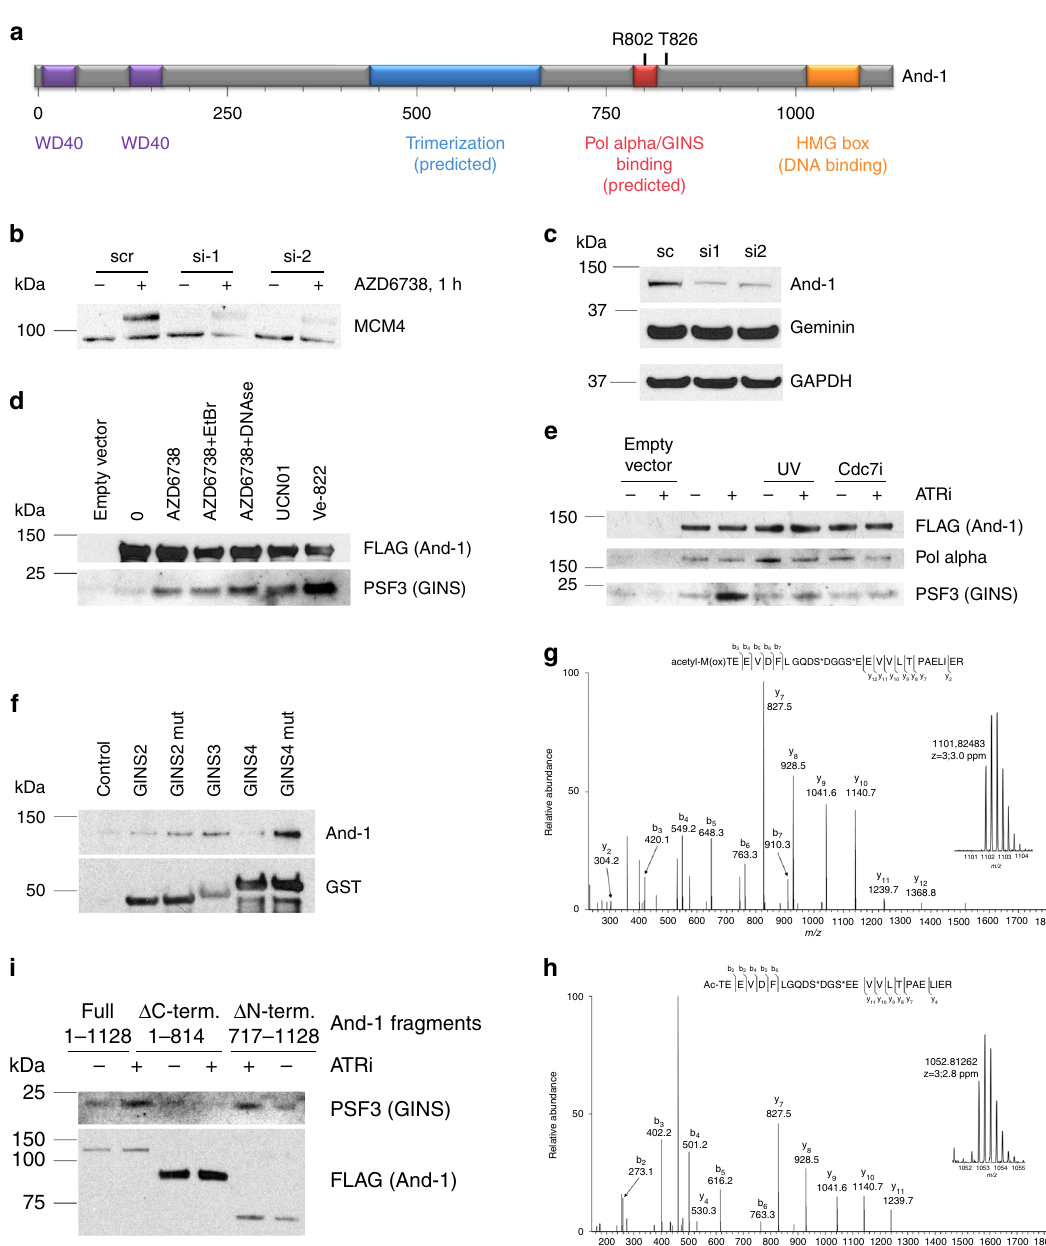
Fig. 3 ATR inhibition causes an increased Cdc7-dependent association between And-1 and GINS. a Schematic representation of And-1 structure and functions. b 293T cells were transfected with siRNAs against And-1. Forty-eight hours later, cells were treated with vehicle or AZD6738 for 1 h and fractionated. Western blot of the nuclease-insoluble fraction is shown. c Whole-cell lysate western blot of 293T cells transfected with siRNAs against And- 1. d 293T cells were transfected with empty vector or vector expressing And-1-FLAG. Forty-eight hours later, cells were treated with 5 μ M ATRi (AZD6738), 200 nM Chk1i (UCN01), or 5 μ M ATRi (Ve822). Cells were lysed, and And-1-FLAG was immunoprecipitated and eluted with FLAG peptide. EtBr or DNAse I were added to the indicated samples during the IP. e 293T cells were transfected with empty vector or vector expressing And-1-FLAG. Forty-eight hours later, cells were treated with 5 μ M ATRi (AZD6738). Indicated samples were UV-irradiated at 10 J m − 2 30 ′ before ATRi, Cdc7i was added 15 ′ before ATRi. Cells were lysed, And-1-FLAG was immunoprecipitated and eluted with FLAG peptide. f Wild-type or mutant GINS proteins tagged with GST were expressed in E.coli , puri fi ed using glutathione sepharose. GINS proteins attached to beads were incubated with total cell lysate of 293T cells, washed with lysis buffer, and eluted with glutathione solution. Analysis of the eluted samples is shown. g , h Liquid chromatography-tandem mass spectrometry (LC-MS/MS)-based identi fi cation of two N-terminal phosphorylated structural isoforms of GINS4. g Tandem MS and accurate mass (inset m / z 1101.82483, charge state 3+) of the phosphorylated form of the methionine (oxidized)-containing N-terminal tryptic peptide of GINS4. h Tandem MS and accurate mass (inset m / z 1052.81262, charge state 3+) of the phosphorylated form of the methionine cleaved N-terminal tryptic peptide of GINS4. i 293T cells were transfected with empty vector or vector expressing full size And-1-FLAG or speci fi ed truncation mutants. Forty-eight hours later, cells were treated with 5 μ M ATRi (AZD6738) for 1 h. Cells were lysed, And-1-FLAG was immunoprecipitated and eluted with FLAG peptide. Eluted samples were analyzed by western